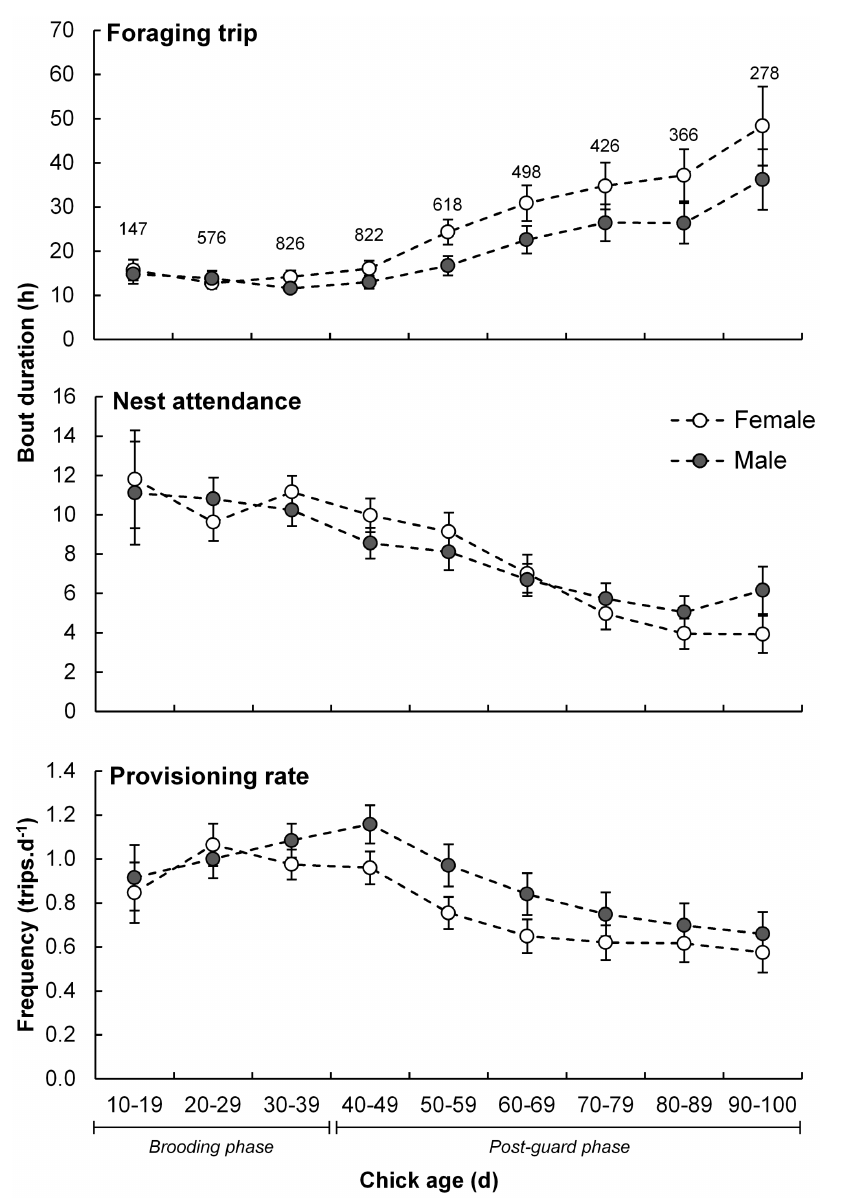
Fig. 1. Sex-specific behavioural parameters of adult Cape gannets at Bird Island, Algoa Bay, as a function of the age of the chicks they are provisioning. Females are represented by white circles and males by dark circles. Total number of foraging trips recorded per chick age category, as well as brooding and post-guard phase of chicks, are indicated.